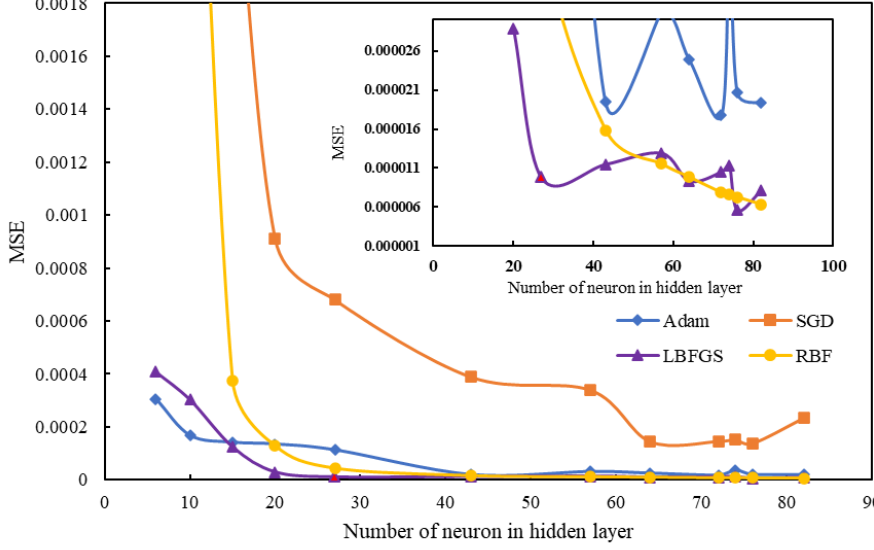
Figure 11. Comparison of the MLP and RBF networks performance optimization.